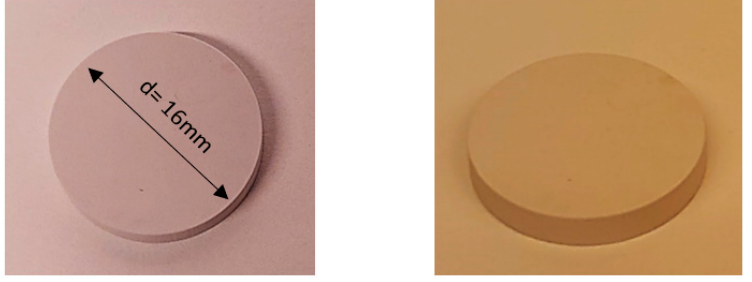
Figure 8. AlN-sample-discs (two views) based on suspension with 46 vol% solid content, green state. CerAMfacturing of these green discs was successfully achieved using the derived parameters. After cleaning the components with a cleaning solution in combination with pressured air, no defects were detected through visual inspection. Afterwards, substrates with inner cooling channels were manufactured (Figure 9). Due to a smaller cross-sectional area, a larger energy dose of 200 mJ/cm 2 was used for layer exposure to ensure that each layer would be adequately connected to the green body.